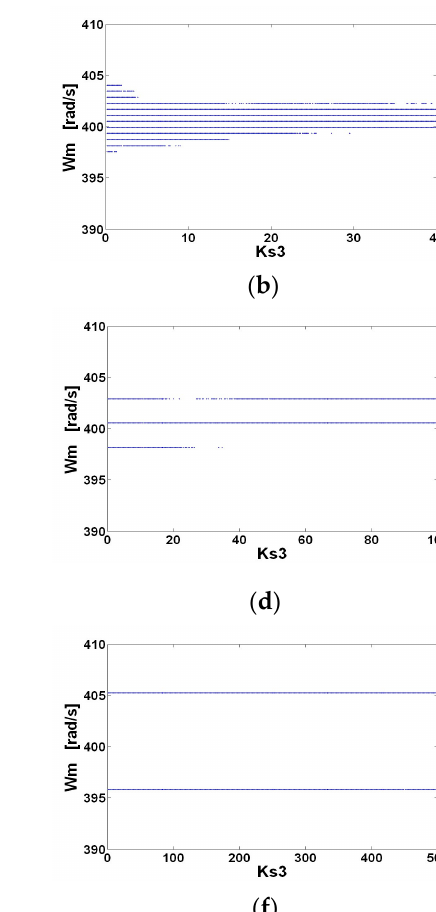
Figure 4. Numerical and experimental bifurcation diagrams for the duty cycle 𝑑 with respect to the control parameter 𝐾 (cid:3020)(cid:2871) . These diagrams are plotted considering the following quantization levels: ( a ) 𝑊 (cid:3040) with 28 bits, analog–digital (ADC) inputs with 12 bits, 𝑑 with 10 bits; ( b ) 𝑊 (cid:3040) with 28 bits, ADC with 12 bits, and 𝑑 with 10 bits; ( c ) 𝑊 (cid:3040) with 26 bits, ADC with 10 bits, and 𝑑 with 8 bits; ( d ) 𝑊 (cid:3040) with 26 bits, ADC with 10 bits, and 𝑑 with 8 bits; ( e ) 𝑊 (cid:3040) with 24 bits, ADC with 8 bits, and 𝑑 with 6 bits; and ( f ) 𝑊 (cid:3040) with 24 bits, ADC with 8 bits, and 𝑑 with 6 bits.